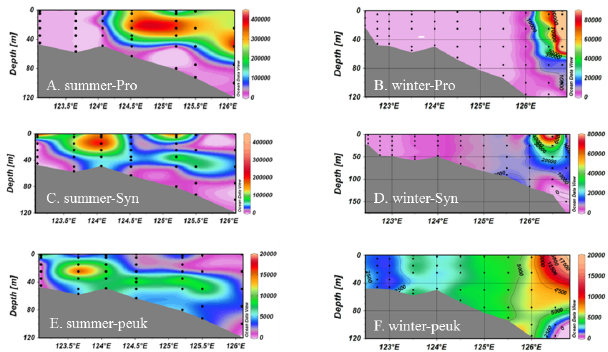
Fig. 5. Vertical profile of abundances (cellsmL − 1 ) of (A, B) Prochlorococcus (Pro), (C, D) Synechococcus (Syn), and (E, F) pi- coeukaryotes (Peuk) during summer and winter along the PN tran-